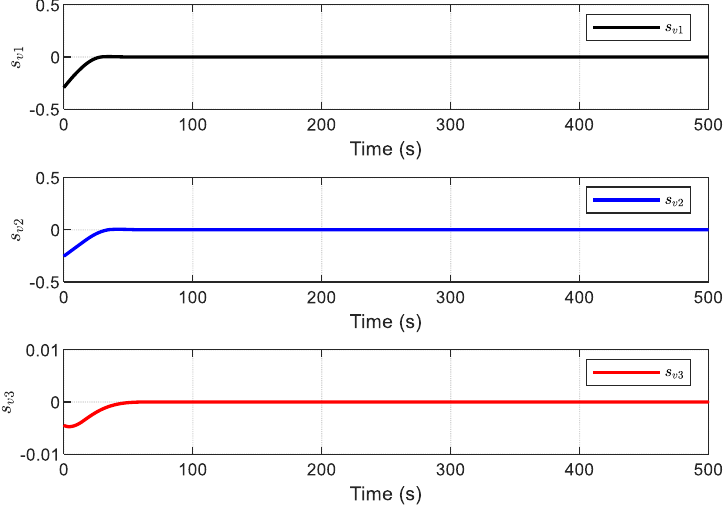
Figure 25. The TSM surface of the controller.